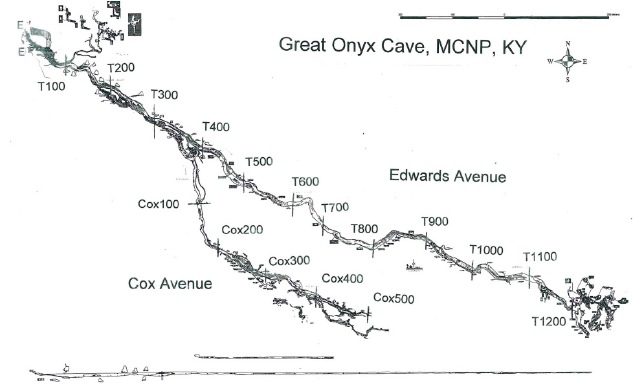
Figure 1. Map of Great Onyx Cave showing sampling sites by 100 m intervals. Gypsum first appears in Edwards Avenue at 310 m, and continues through 1000 m. Locally thick crusts and gypsum flowers occur from approximately 400–900 m. Cox Avenue has much less gypsum throughout the length of the passage, with thinner crusts and no flowers. (Map modified from Cave Research Foundation,